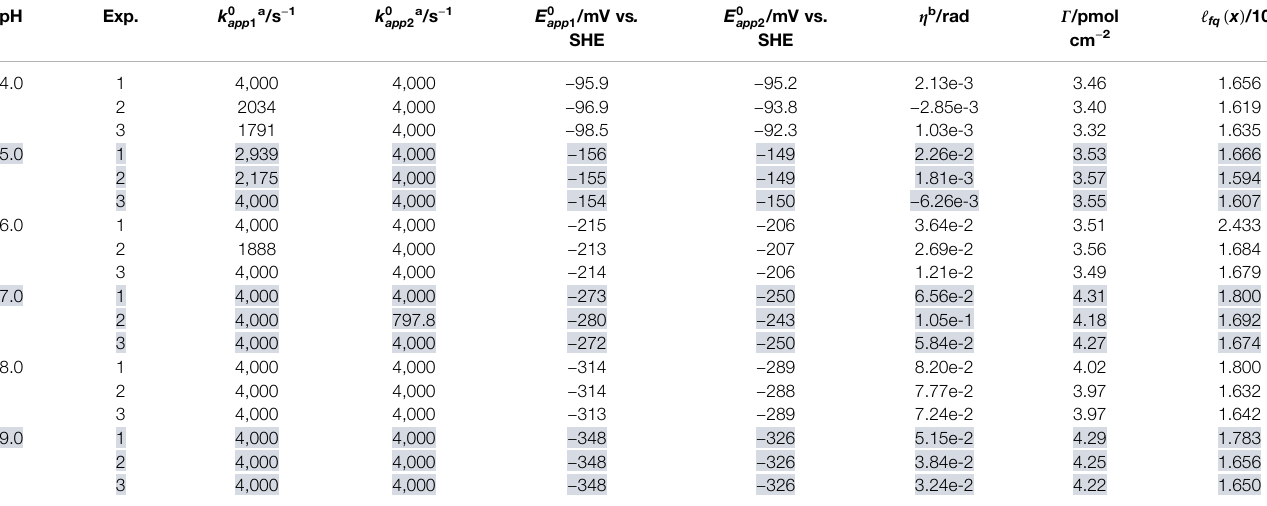
TABLE 1 | Best fi t parameter values extracted when the two-sequential one-electron transfer model ( n 1 (cid:2) n 2 (cid:2) 1) is used to simulate three repeated ] (cid:2) 22.4 mV s − 1 , f (cid:2) 8.96 Hz, Δ E (cid:2) 150 mV H2ase-MFHypD FTACV experiments (Exp. 1, 2, and 3) at each of the pH values 4.0, 5.0, 6.0, 7.0, 8.0, and 9.0. pH Exp.